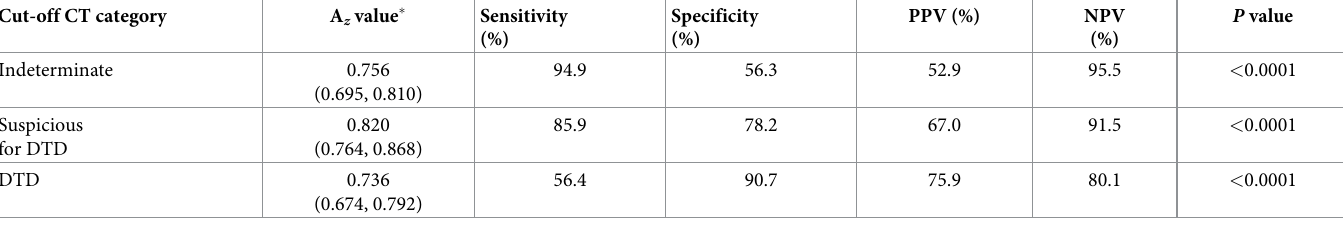
Table 4. Diagnostic accuracy of the computed tomography classification for differentiating diffuse thyroid disease from normal thyroid parenchyma in 229 patients. Cut-off CT category